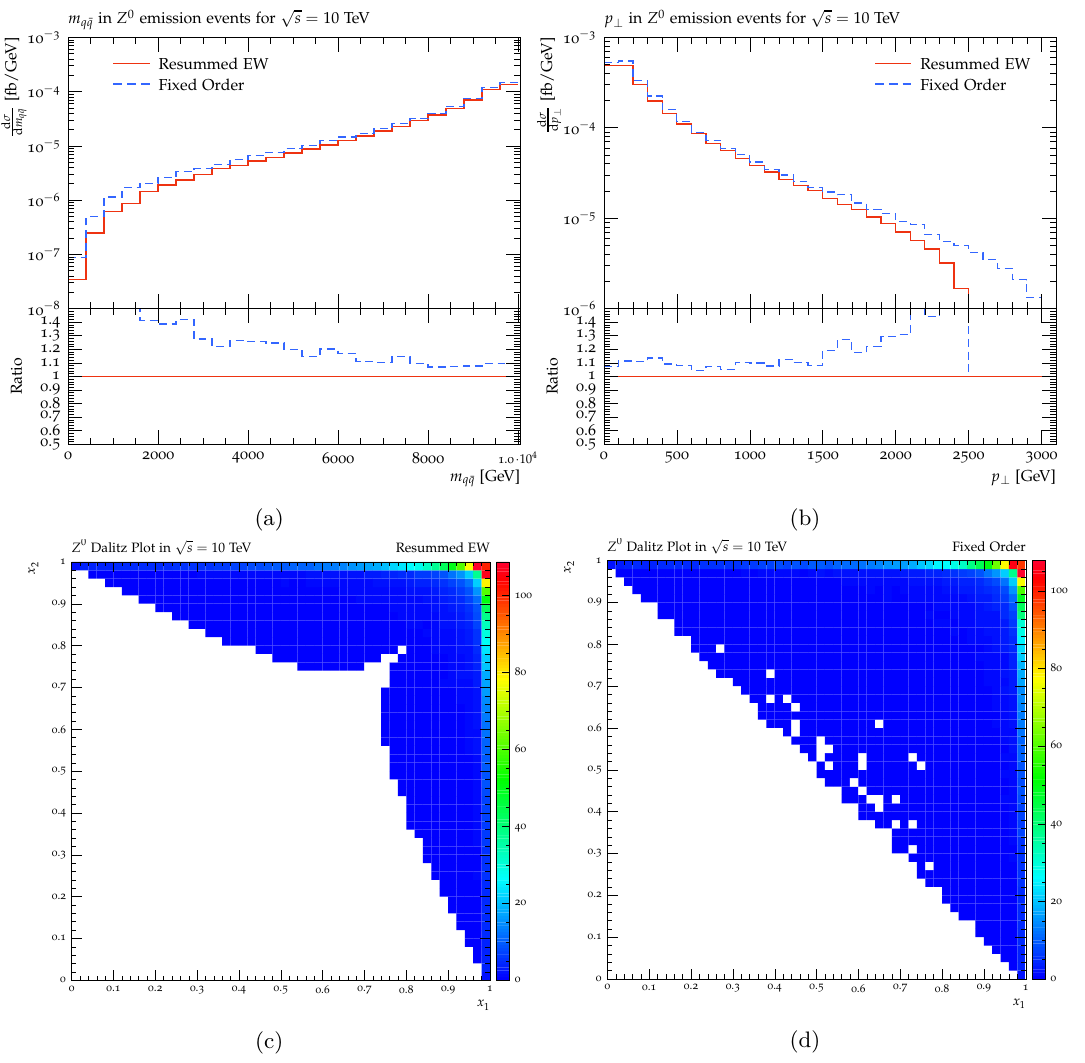
√ s = 10 TeV. The notation